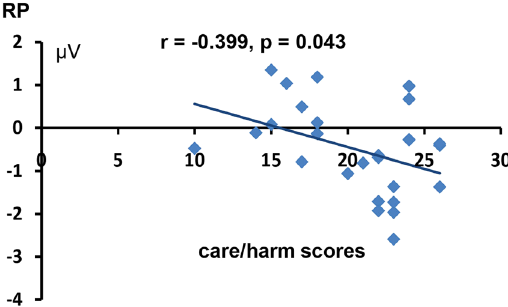
Figure 2. Correlation between the net moral RP effect and the harm/care scores of the MFQ-30.